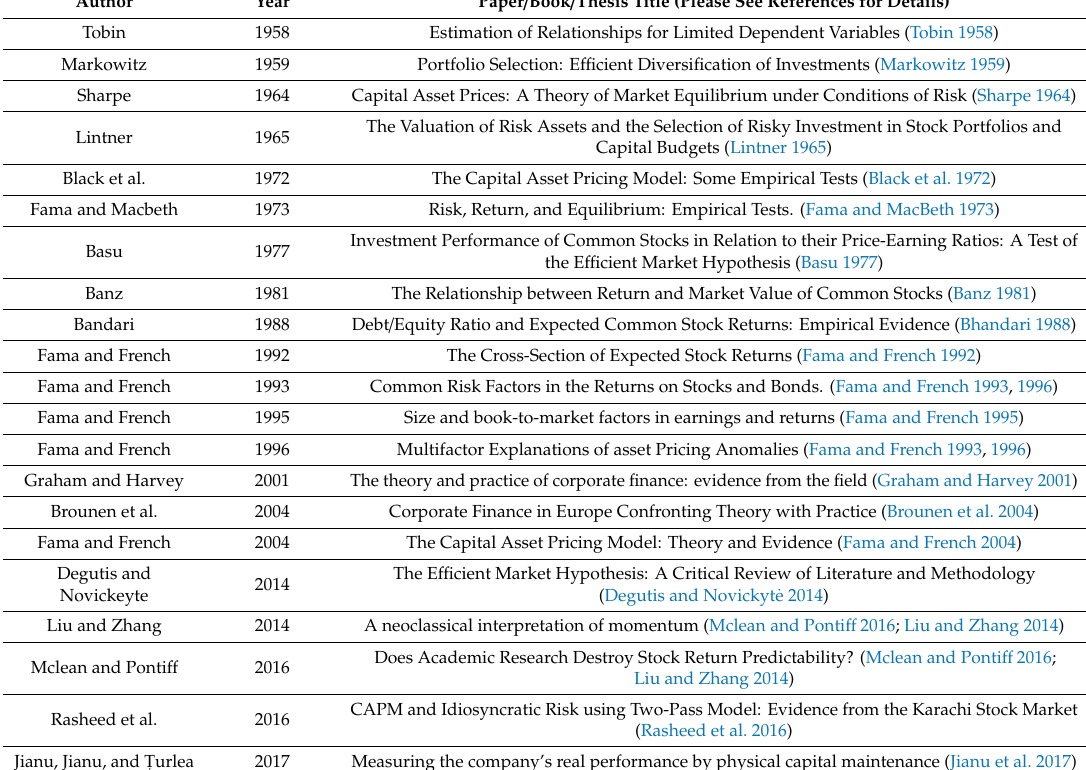
Table 4. Selected work on Excess returns and Valuation